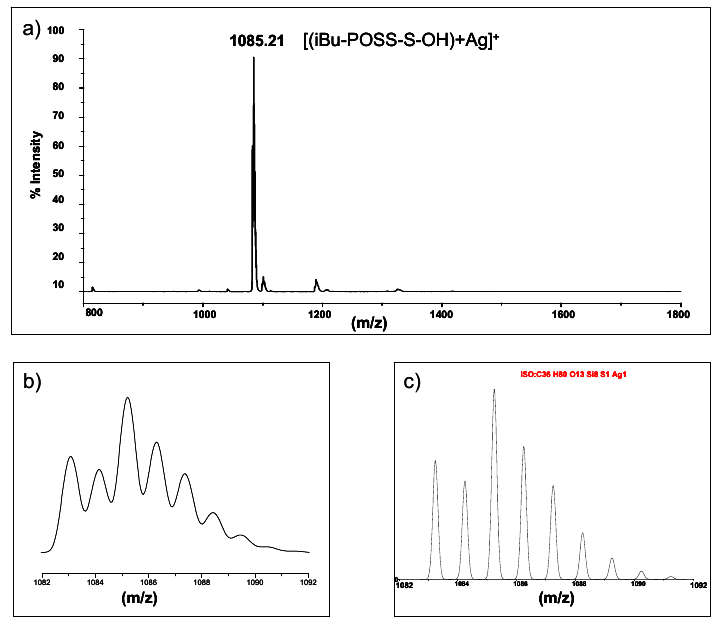
Figure 4. MALDI-TOF spectra (linear mode, AgTFA added) of the (iBu-POSS-S-OH)(4), C 36 H 80 O 13 S 1 Si 8 , M = 977.70. ( a ) containing 92.54% of reactive –(CH 2 ) 2 S(CH 2 ) 6 OH groups; ( b ) expansion of 1082–1092 m / z range; ( c ) simulated